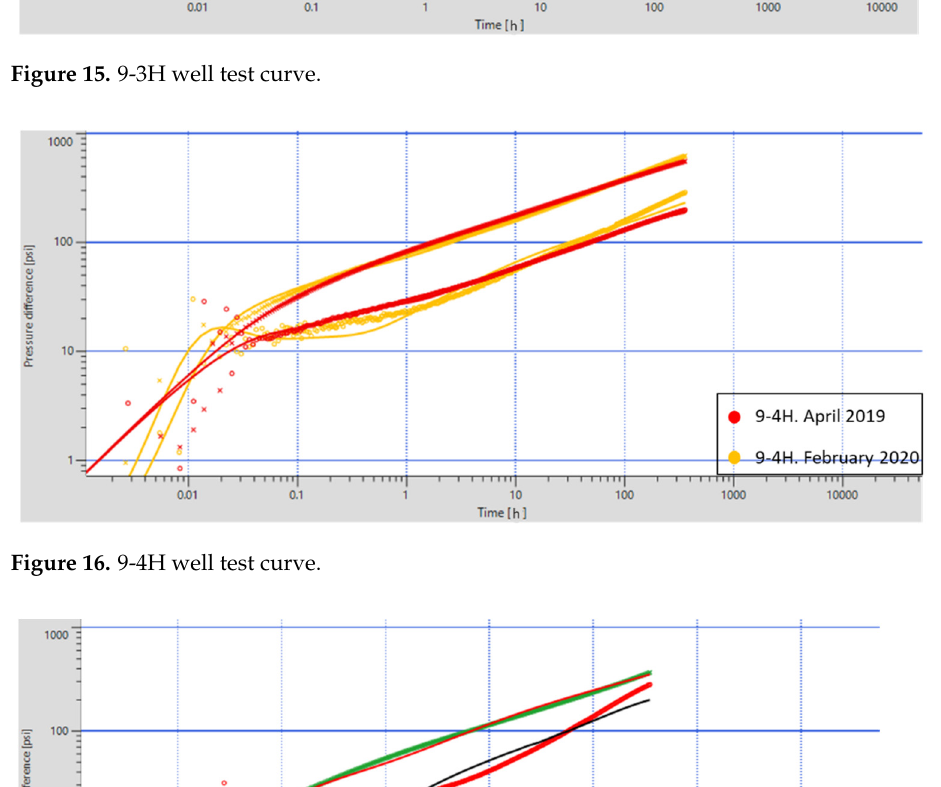
Figure 18. 9 ‐ 2H well test curve.